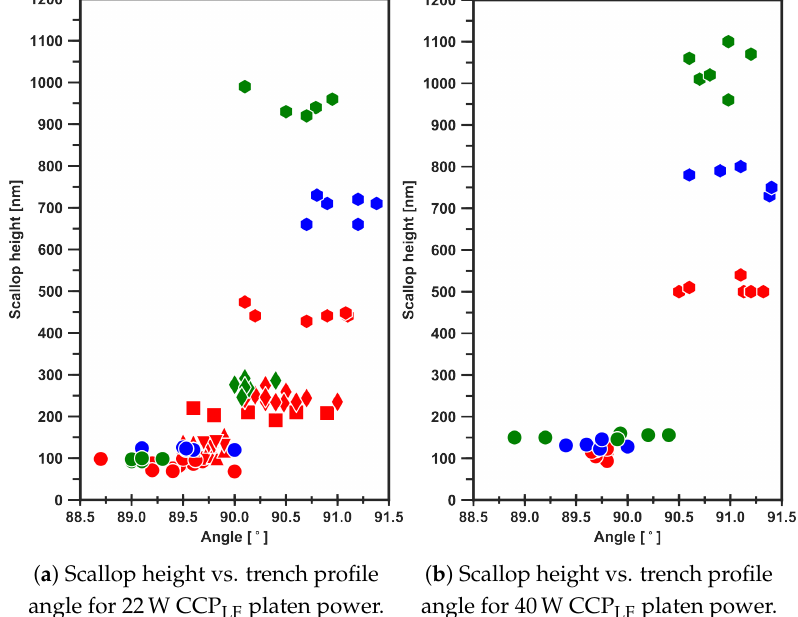
Figure 15. Two graphs with the relation of scallop height vs. trench sidewall angle for trenches etched with ( a ) 22W and ( b ) 40W CCP LF platen power for different etch process pressures and etch-cycle times. Legend: The figures are representing = 1.5s, = 1.75s, = 2.0s, = 3.0s, and = 5.0s. The colours are representing = 16mTorr, = 30mTorr, and =